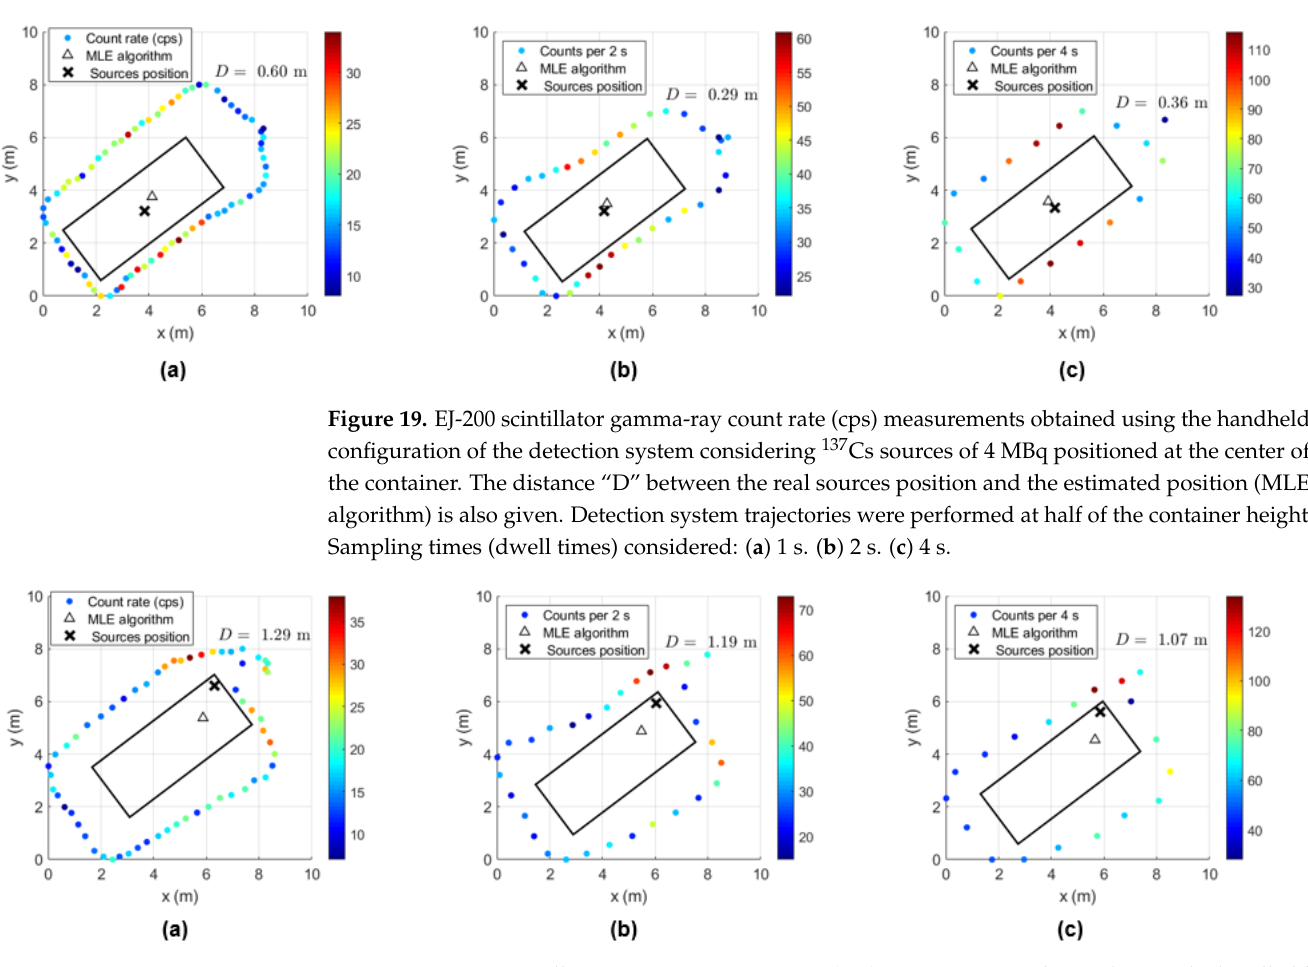
Figure 20. EJ-200 scintillator gamma-ray count rate (cps) measurements obtained using the handheld configuration of the detection system considering 137 Cs sources of 4 MBq positioned at the bottom corner of the container. The distance “D” between the real sources position and the estimated position (MLE algorithm) is also given. Detection system trajectories were performed at half the container height. Sampling times (dwell times) considered: ( a ) 1 s. ( b ) 2 s. ( c ) 4